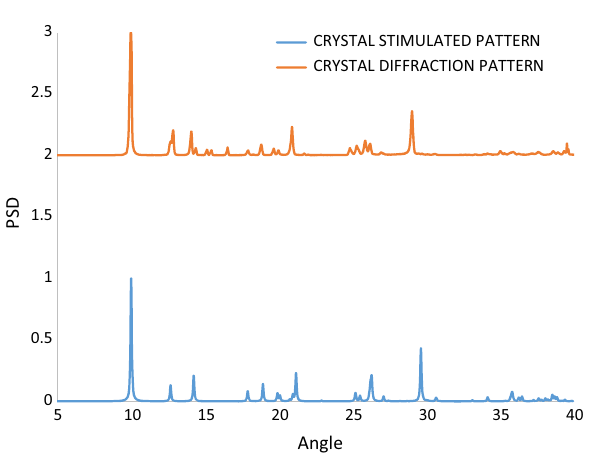
Fig. 7 Superimposition of crystal stimulation and experimental high- resolution diffraction pattern of